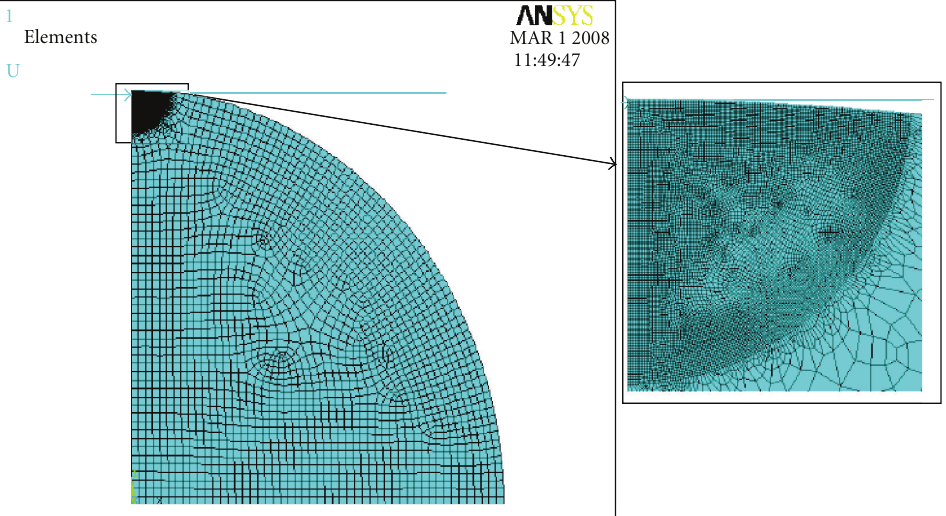
Figure 2: Meshed model of the hemispherical contact.